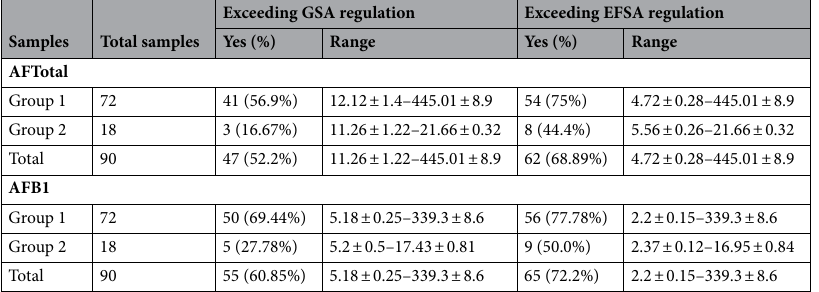
Table 8. Proportions of samples that exceeded AF Total and AFB 1 and limits of Ghana Standard Authority (GSA) and the European Food Safety Authority (EFSA). European Union Food Safety (EFSA) limit for AF Total = 4 µg kg −1 . European Union Food Safety (EFSA) limit for AFB1 = 2 µg kg −1 . Ghana Standards